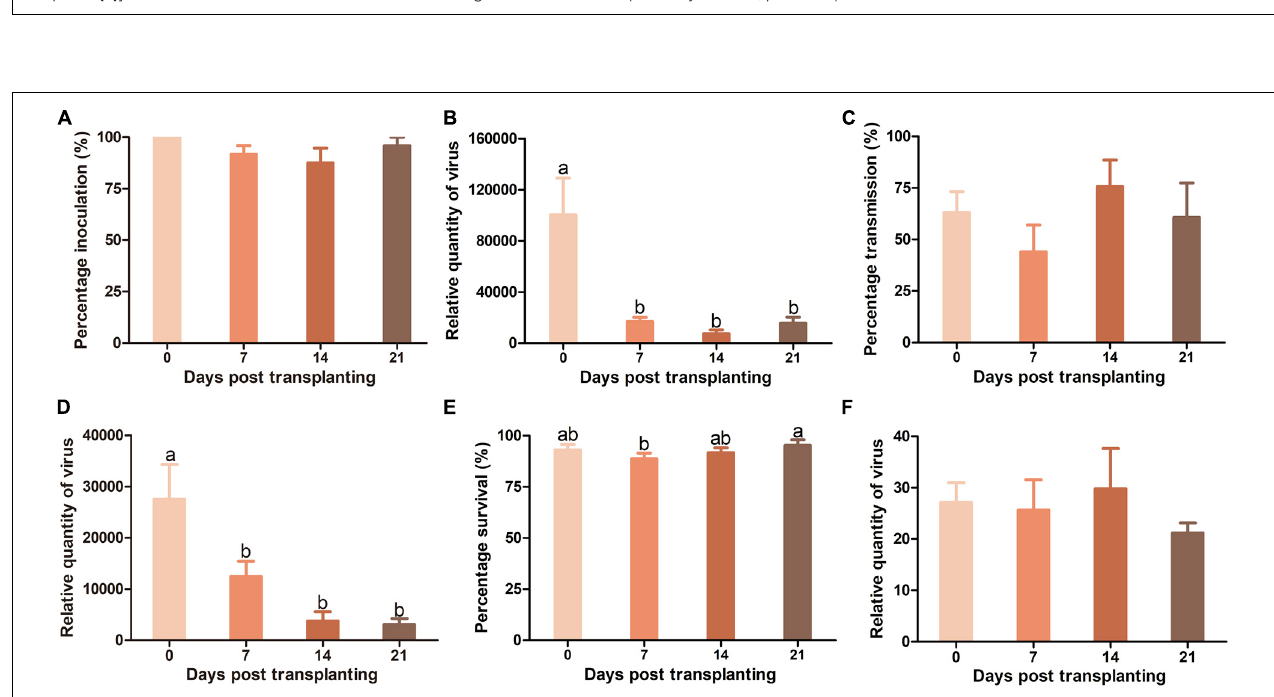
FIGURE 5 | Resistance against tomato yellow leaf curl virus (TYLCV) in Hezuo903 seedlings of 0, 7, 14, and 21 DPT. (A) Percentage of TYLCV-infected plants in agro-inoculated plants; (B) Relative quantity of virus in agro-inoculated plants; (C) Percentage of TYLCV-infected plants in whitefly-inoculated plants; (D) Relative quantity of virus in whitefly-inoculated plants; (E) Whitefly survival on tomato seedlings; (F) Relative quantity of virus in whiteflies recovered post virus transmission. Values are means ± SEM [ n = 3 and in each replicate 6–10 plants were used for panels (A,C) ; n = 7–8 for panels (B,D) ; n = 21–24 for E; n = 3 for panel (F) ]. Different letters above the columns indicate significant differences (one-way ANOVA, p <